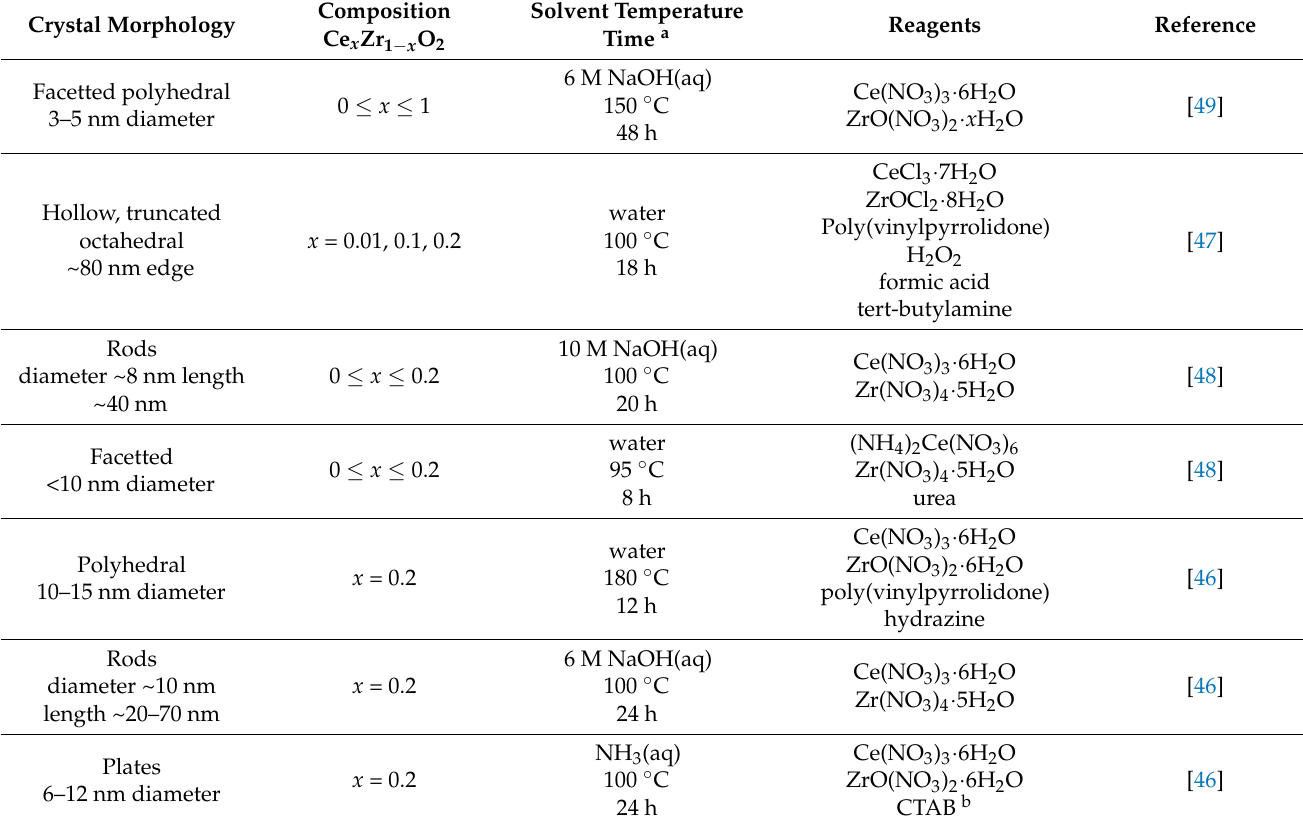
Table 1. Summary of solvothermal conditions used to prepare various crystal morphologies of Ce x Zr 1 − x O 2 . Crystal